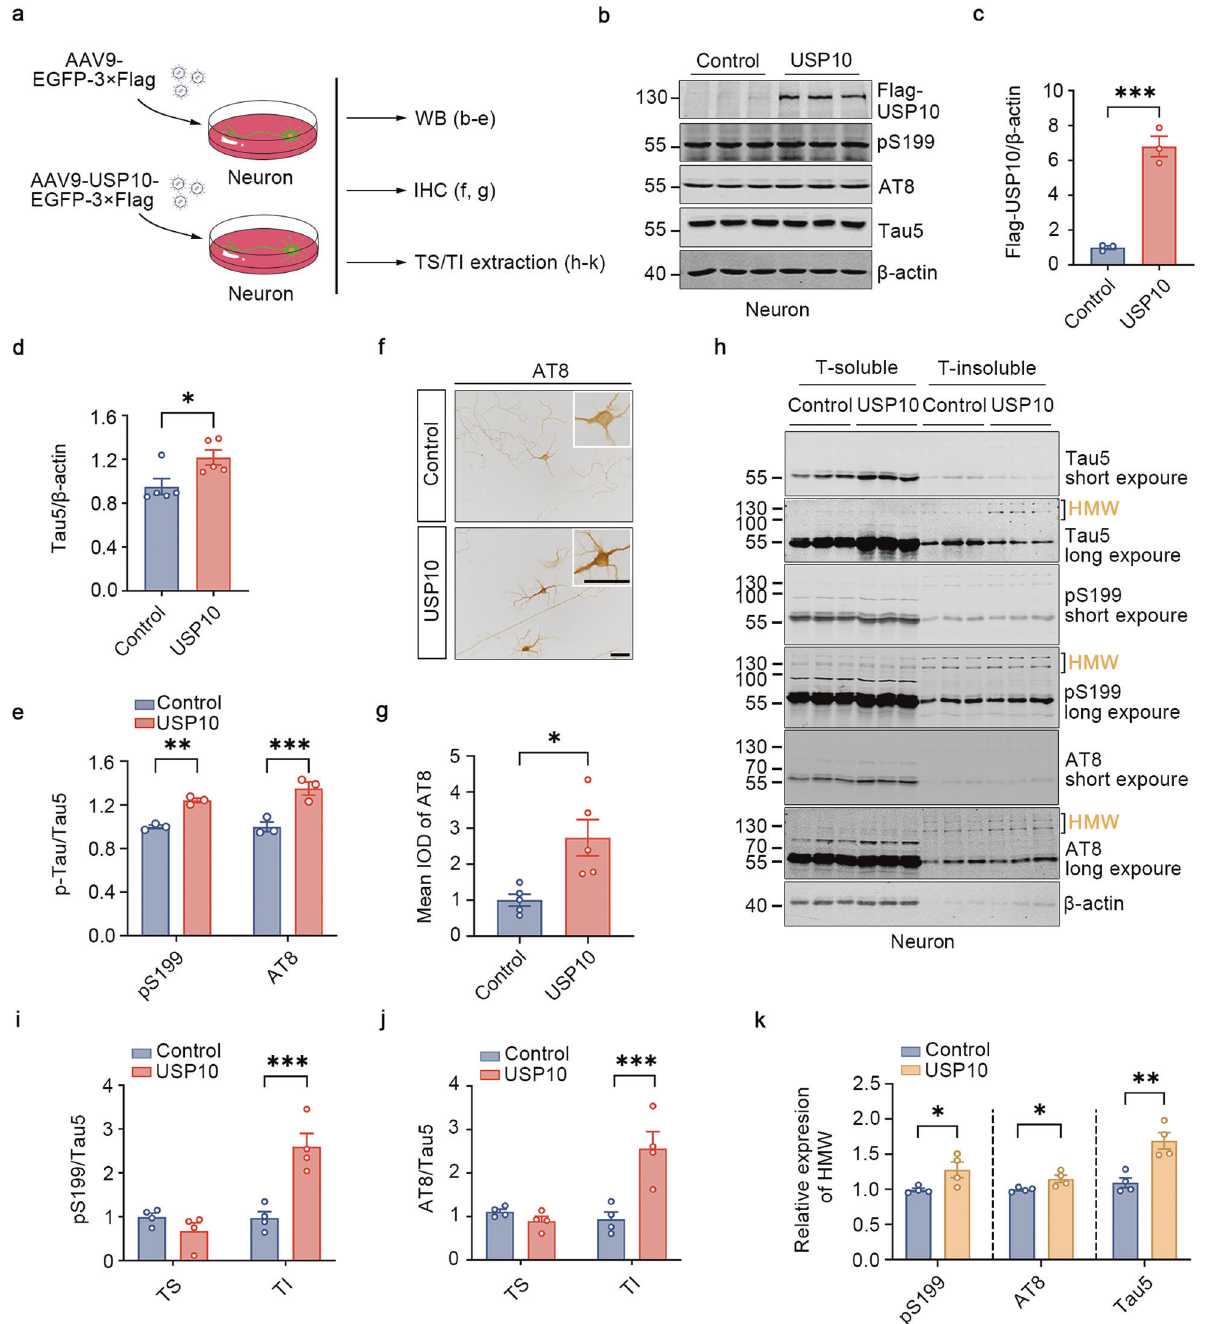
Fig. 3 Overexpression of USP10 induces Tau aggregation in primary neurons. a A Schematics of the experimental design. b Primary neurons were infected with AAV9-FLAG-USP10 on DIV4, MOI = 10 5 , and 7 days later, samples were extracted and subjected to western blotting. c – e Graph showing normalized protein levels of Flag-USP10, pS199, AT8, and Tau5. f Immunocytochemistry showed the distribution of AT8 expressing USP10 compared to control. Scale bars, 50 μ m, inset also 50 μ m. g Quanti fi cation of the mean of integrated optical density (Mean IOD), 3-10 cells per fi eld of view (FOV) were counted, and fi ve different FOV were taken in each group. h Neurons expressing USP10 were lysed, and 0.1% Triton-100 soluble and insoluble fractions were extracted as recommended by the protocol. WB results showed the level of Tau5, pS199, and AT8 (short exposure or long exposure). 100 – 130kd is considered to be the high molecular weight (HMW) of aggregated Tau proteins. i , j Graphs showing the normalized protein levels of AT8 and pS199 in T-soluble fractions and T-insoluble fractions under the aforementioned conditions. k HMW total Tau and p-Tau of insoluble fractions were quanti fi ed. Data are presented as mean ± SEM. * P < 0.05; ** P < 0.01; *** P < that the peptides reversed Tau hyperphosphorylation and Moreover, we infected primary neurons at DIV4 with AAV9- decreased the level of total Tau (Fig. 6e – h). On the other hand, USP10 for 3 days and incubated them with 50 μ M of Tau307- non-ubiquitination mimics mutant peptides, Tau307-326Q + 326K + Tau341-378K for 48 h. In line with the cell line experiment, Tau341-378Q, in which lysine residues (K) are substituted with western blotting results from lysates or primary neurons showed